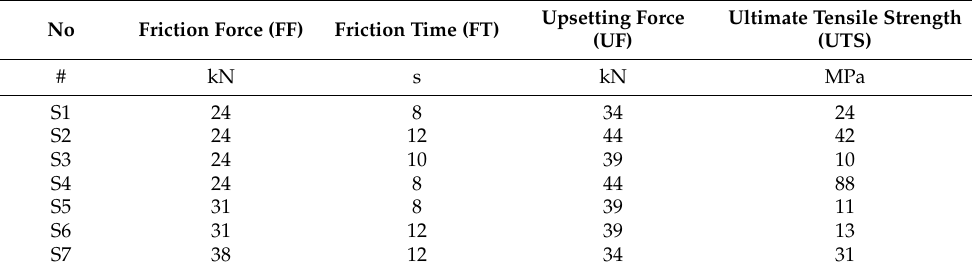
Table 2. The welding parameters used in the experiment and UTS results.